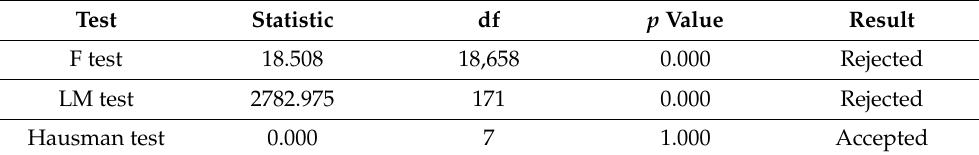
Table 7. Examination results of panel data analysis-based surface texture